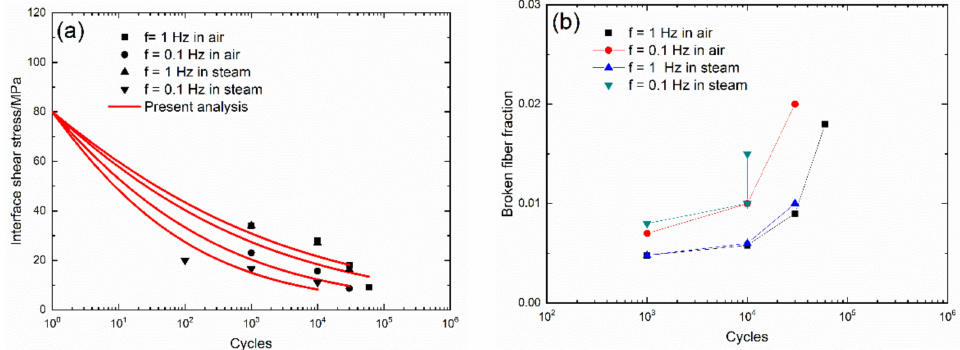
Figure 12. ( a ) Experimental and predicted interface shear stress ( τ i ) versus cycle number curves; and ( b ) the broken fiber fraction (P) versus cycle number curves of 2D woven self-healing Hi-Nicalon TM SiC / [SiC-B 4 C] composite under σ max = 140 MPa at 1200 ◦ C in air and in steam atmospheres. ◦ At T = 1200 C in an air atmosphere with f = 1 Hz, the interface shear stress ( τ i ) decreases from = 34 MPa at N = 1000 to τ = 9.2 MPa at N = 60,000, and the broken fiber fraction (P) increases from τ i i P = 0.0048 to P = 0.018; when f = 0.1 Hz, the interface shear stress ( τ i ) decreases from τ i = 23 MPa